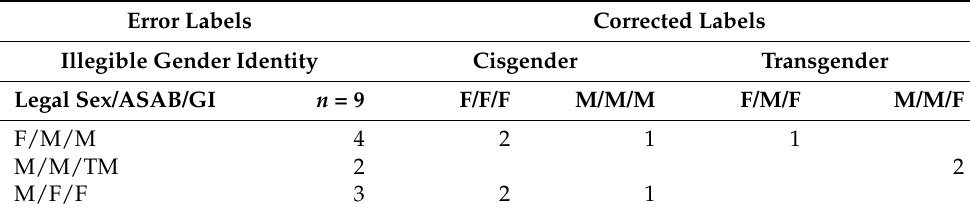
Table 1. Gender identity data organized by assigned sex at birth (ASAB) for all Rush University Medical Center patients, 12 years and older, with unplanned hospital encounters in 2020 (N = 49,314). Assigned Sex at Birth Gender Female Identity